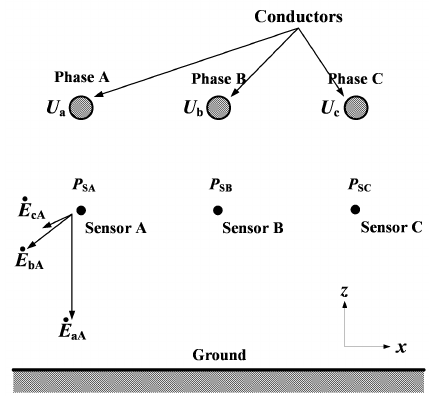
Figure 1. Schematic diagram of the measuring principle. U a , U b , U c —potentials on phase conductors; P SA , P SB , P SC —positions where electric field sensors are set; E aA , E bA , E cA —electric field produced by U a , U b , and U c, respectively at position P SA .